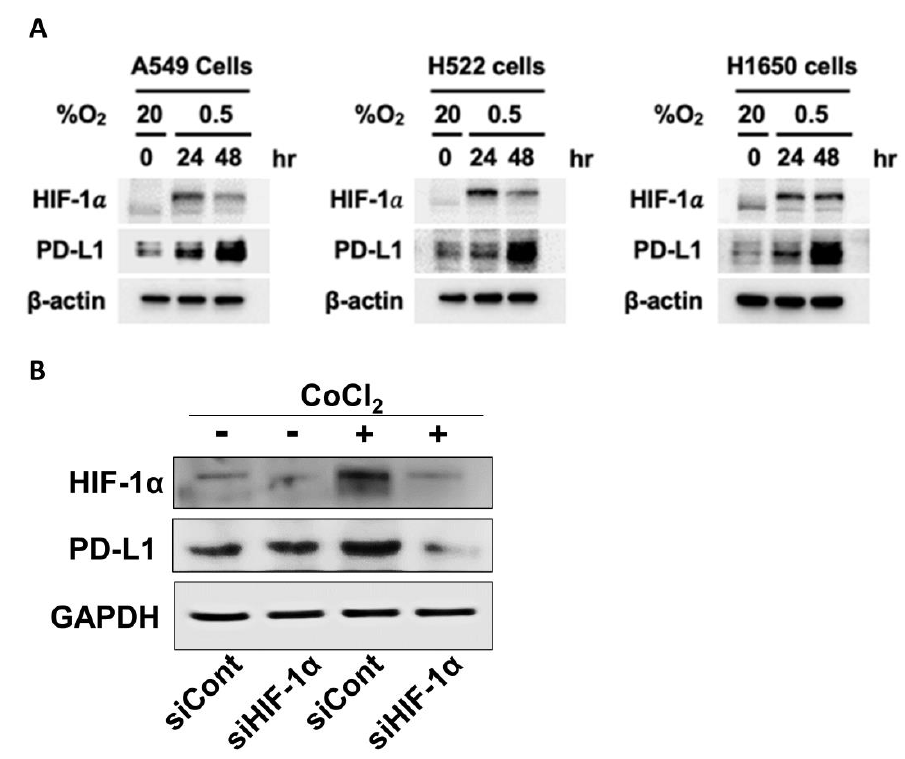
Figure 3. ( A ). Western blot analysis for expression of HIF-1 α and PD-L1 in human lung cancer cell lines. A549, H522, and H1650 (obtained from American Type Culture Collection) were incubated under hypoxic conditions (0.5% oxygen) in an InvivO 2 500 hypoxia workstation (The Baker Company, Sanford, ME, USA) for 24 and 48 h. Cells were lysed using ice-cold RIPA buffer containing a protease inhibitor cocktail (Roche Applied Science), sodium orthovanadate (Sigma-Aldrich, St. Louis, MO, USA), and sodium fluoride (Sigma-Aldrich). Proteins in whole-cell lysates were resolved by sodium dodecyl sulfate-polyacrylamide gel electrophoresis (SDS-PAGE) and analyzed by immunoblotting. Signals were detected using enhanced chemiluminescence reagents (Pierce). The expressions of both HIF-1 α and PD-L1 increased under the hypoxia. (Unpublished results by H. Park). ( B ). Western blot analysis for the expression of HIF-1 α and PD-L1 expression in FSaII cells incubated in oxic (DMSO) or hypoxia-mimic medium (250 µ M CoCl 2 ) for 8 h. Proteins in whole-cell lysates were resolved by sodium dodecyl sulfate-polyacrylamide gel electrophoresis (SDS-PAGE) and analyzed by immunoblotting. Hypoxia increased the expression of HIF-1 α and PD-L1 and knocking out of HIF-1 α with siRNA downregulated the expression both HIF-1 α and PD-L1. (Unpublished results by M.